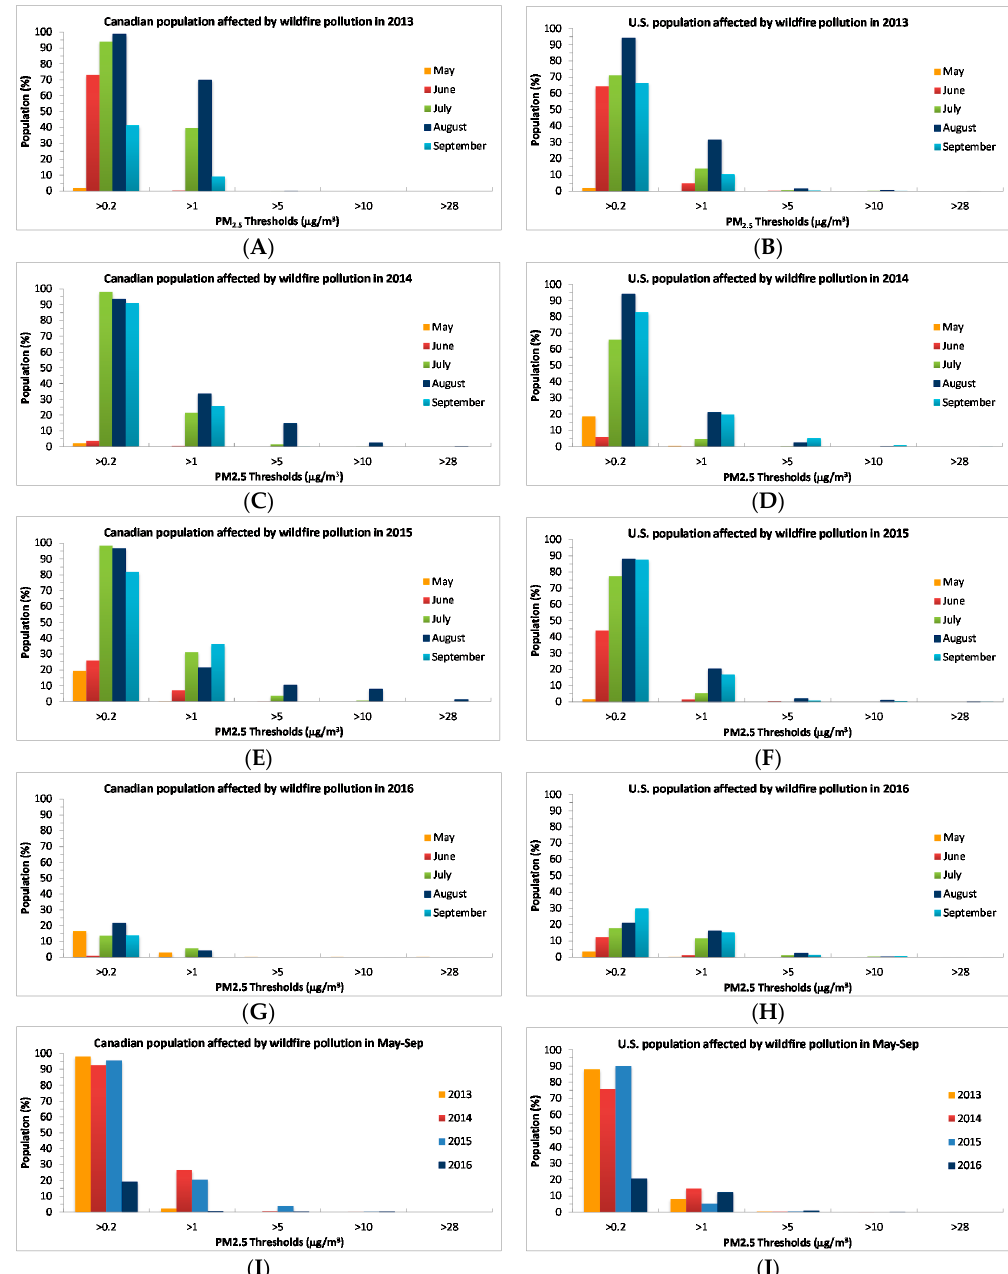
Figure 8. Percentage of population in Canada (left panels: A , C , E , G , and I ) and the USA (right panels: B , D , F , H , and J ), affected by wildfire pollution above five PM 2.5 concentration thresholds based on the average monthly and seasonal fire-PM 2.5 contribution to total average monthly and seasonal surface PM 2.5 concentrations for four wildfire seasons (2013–2016). The percentage of the affected population for Canada and the USA was calculated using the 2016 Canadian and the 2010 U.S. censuses, respectively. See also Tables S3 and S4.